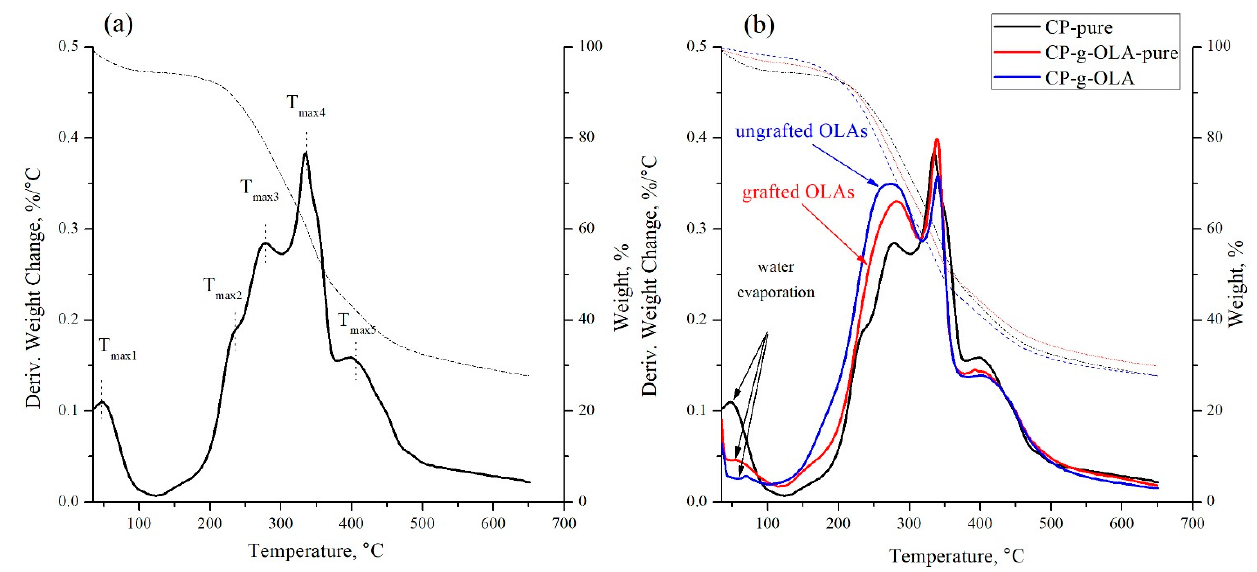
Figure 5. TG and DTG curves of ( a ) CP-pure filler; ( b ) overlaid TG and DTG curves of CP-pure, CP-g-OLA, CP-g-OLA-pure fillers. Table 6. TGA results of the fillers.